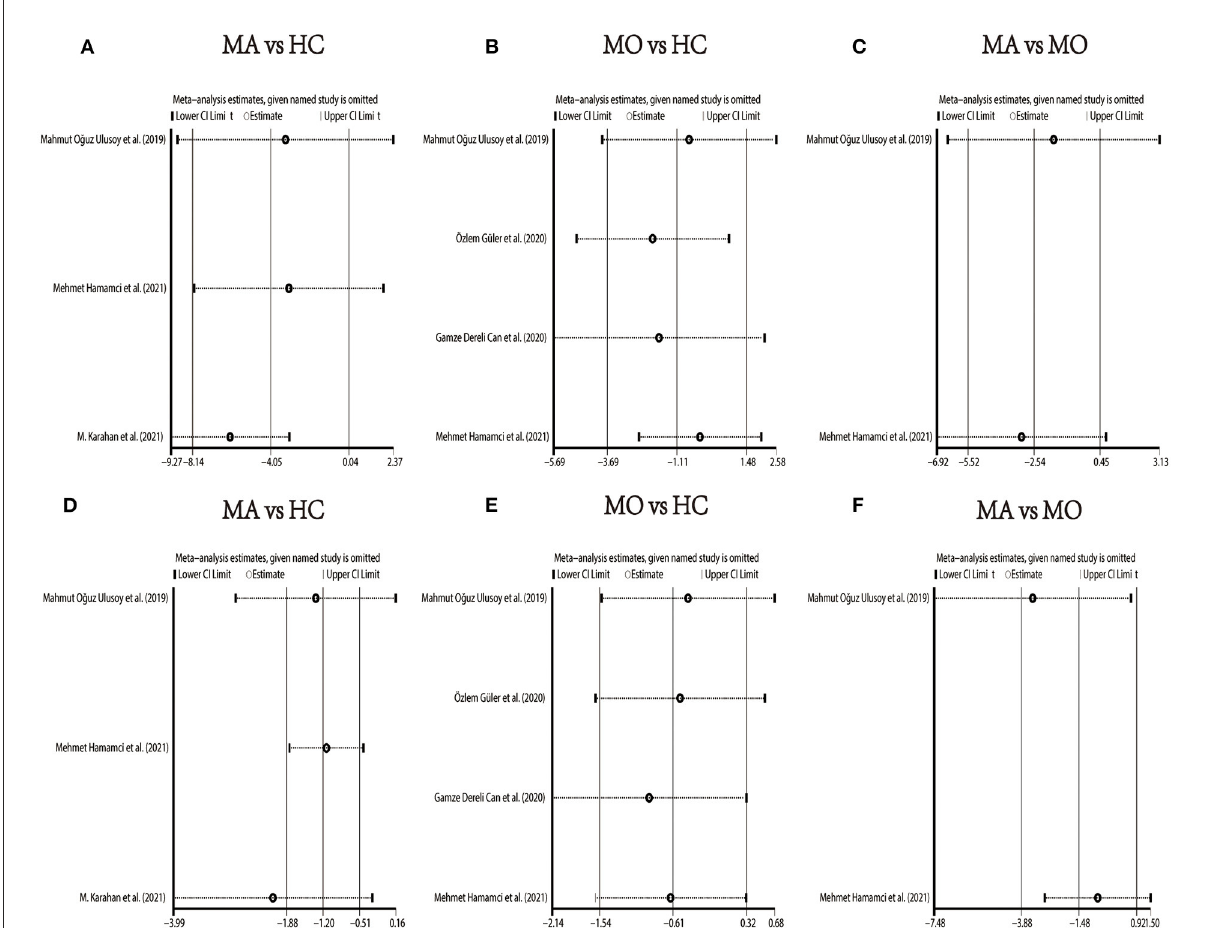
FIGURE9 Sensitivity analysis data for studies included reported VD in the DCP. (A) foveal VD comparison of MA and HC; (B) foveal VD comparison of MO and HC; (C) foveal VD comparison of MA and MO; (D) parafoveal VD comparison of MA and HC; (E) parafoveal VD comparison of MO and HC; (F) parafoveal VD comparison of MA and